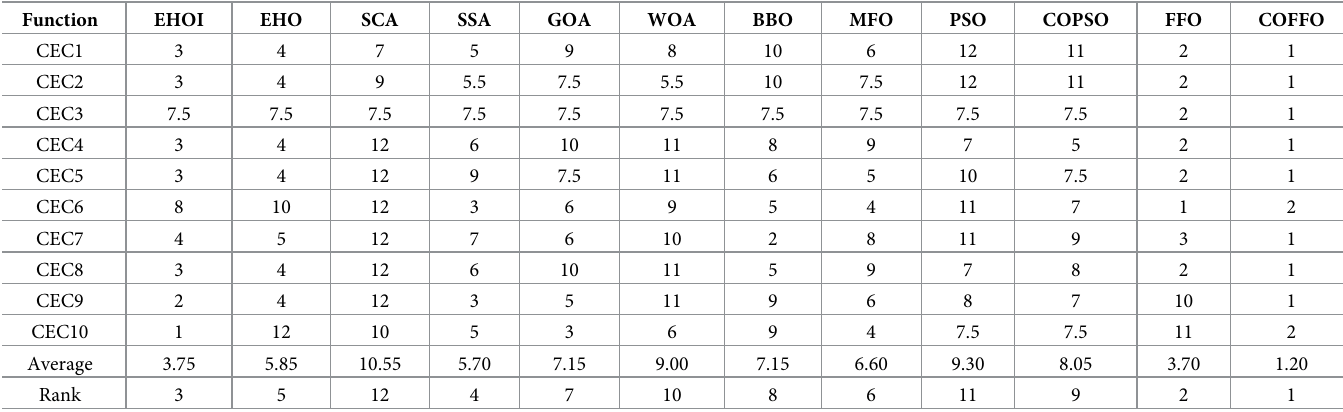
Table 4. Friedman ranks of tested methods on CEC2019 benchmark functions.